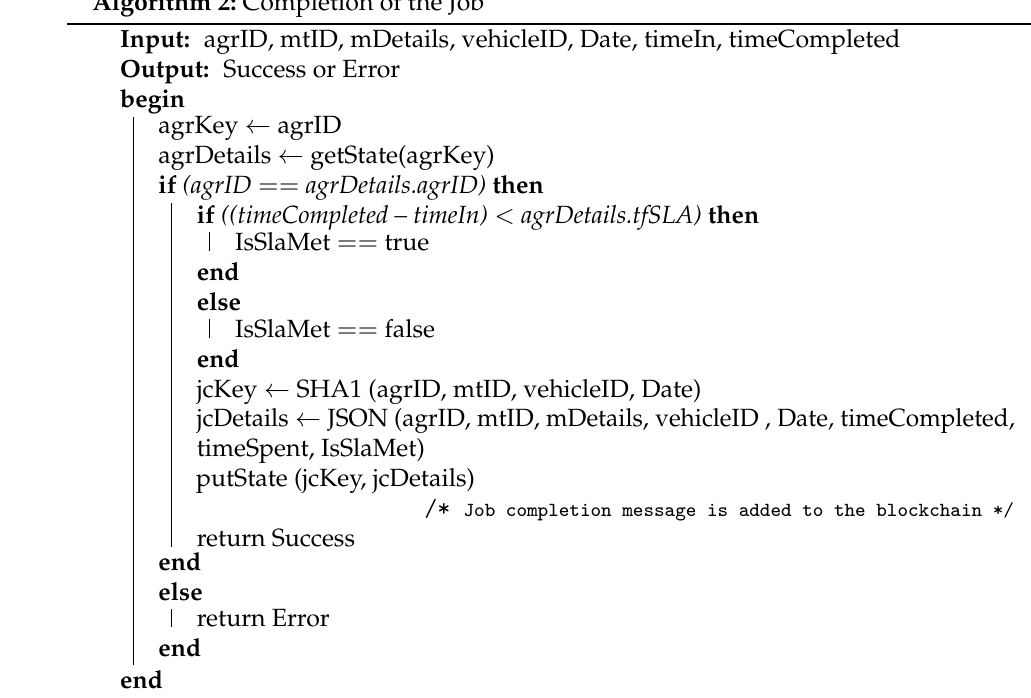
Algorithm 2: Completion of the Job